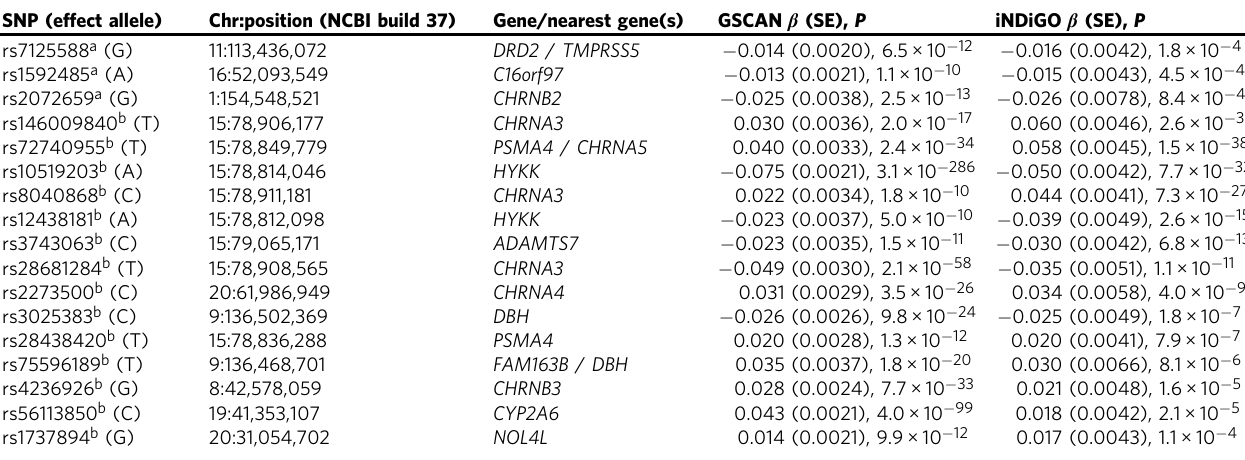
Table 2 Single nucleotide polymorphisms (SNPs) identi fi ed as genome-wide signi fi cant for cigarettes per day (CPD) by the GWAS and Sequencing Consortium of Alcohol and Nicotine use (GSCAN) consortium and associated with nicotine dependence (ND) in the Nicotine Dependence GenOmics (iNDiGO)